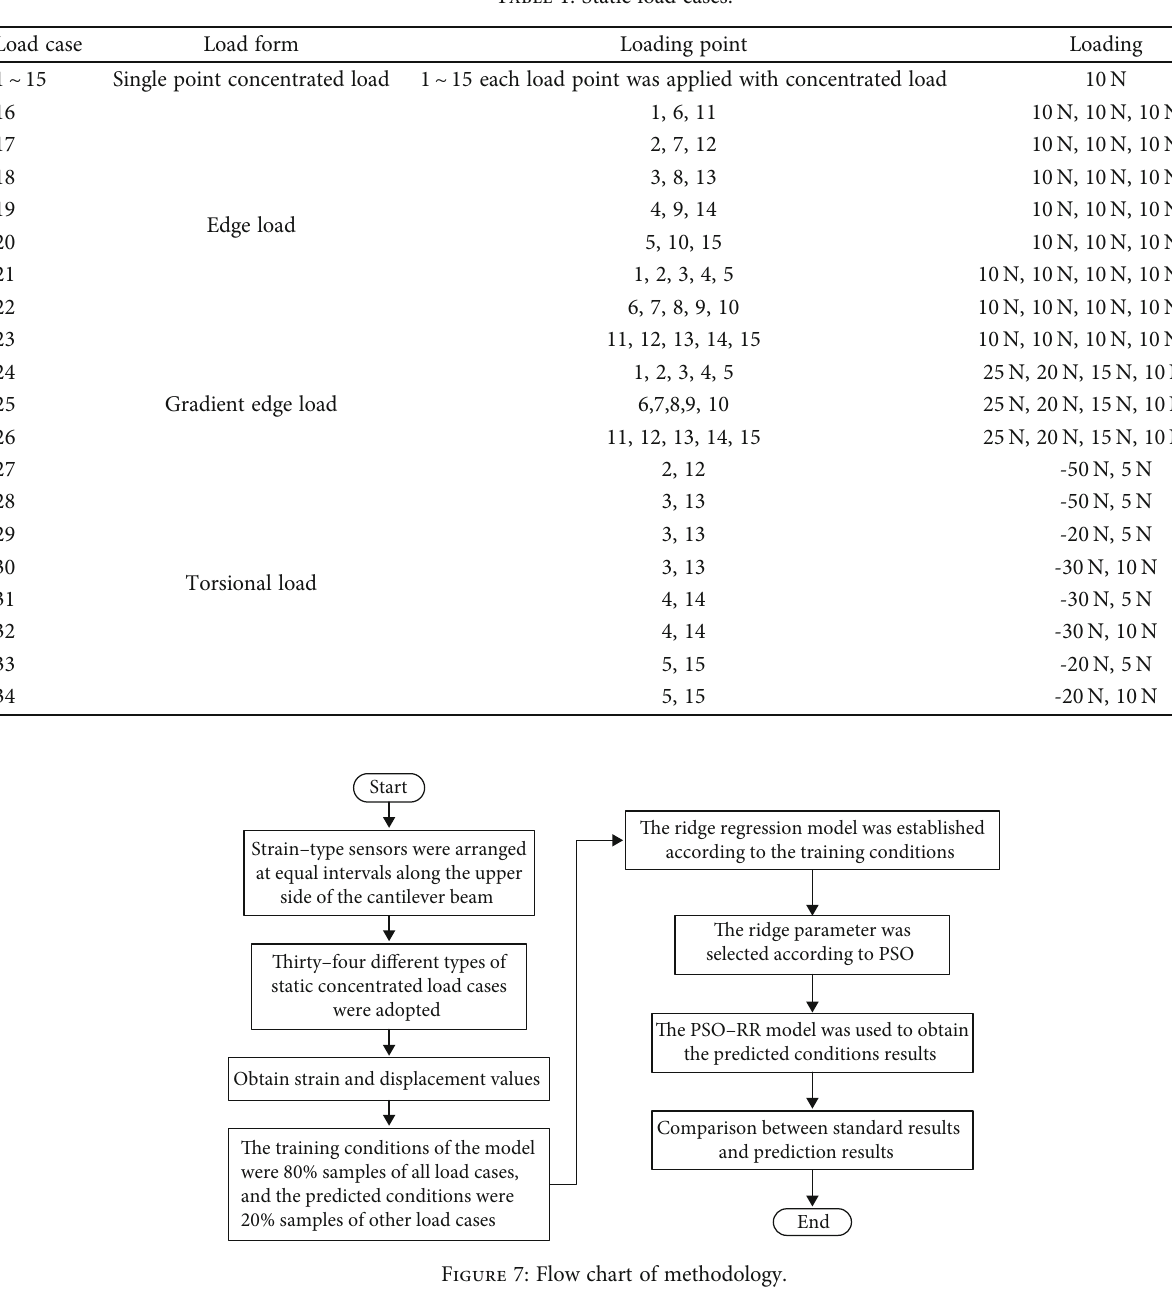
Table 1: Static load cases.